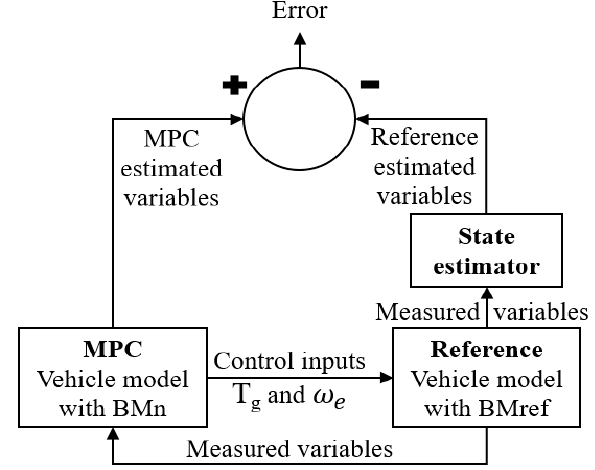
Figure 4. Control loop for the sensitivity analysis.